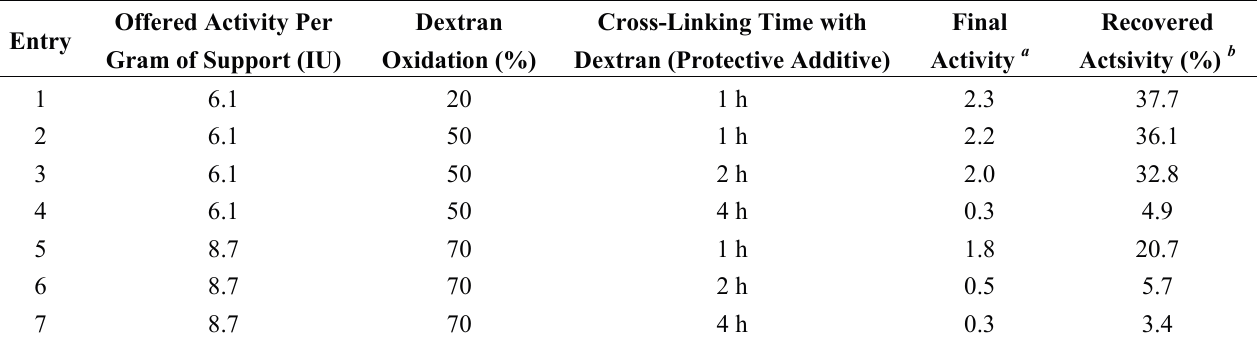
Table 3. Immobilization of Bp NDT on PEI-functionalized agarose and cross-linking with aldehyde-dextran (MM 20